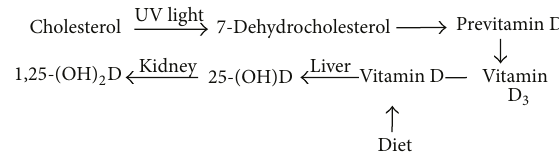
Figur e 1:Synthesis and metabolism of vitamin D [14]. 25-(OH)D: 25-hydroxyvitamin D; 1,25-(OH) 2 D: 1,25-hydroxyvitamin D.